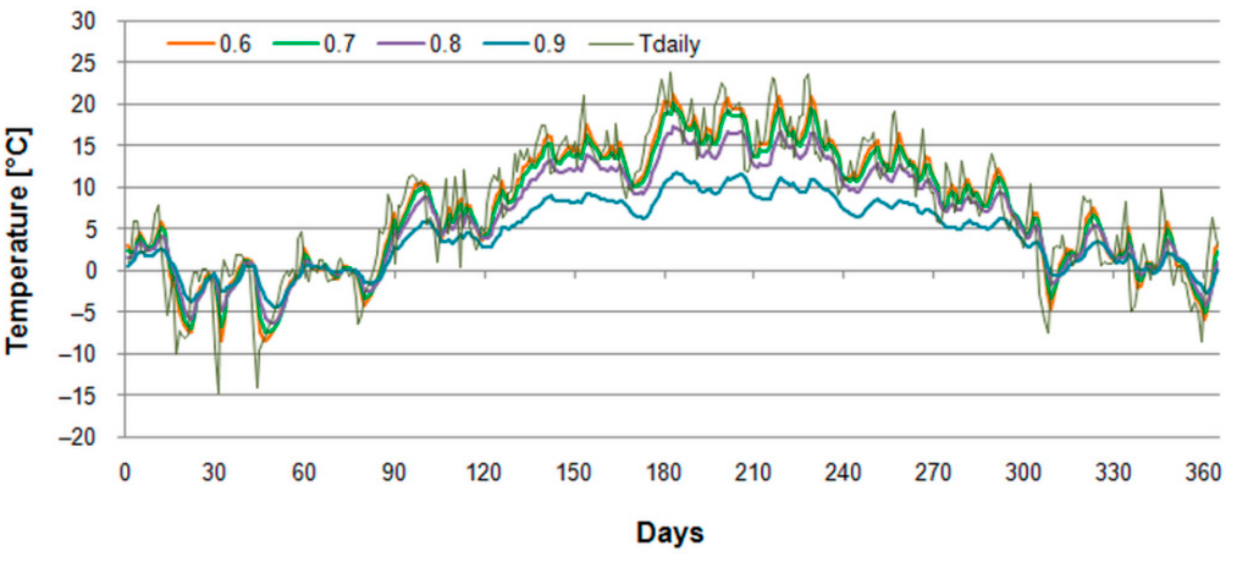
Figure 6. Daily average outdoor air temperature (T daily ) and running mean outdoor temperature for α = 0.6, α = 0.7, α = 0.8, and α = 0.9.